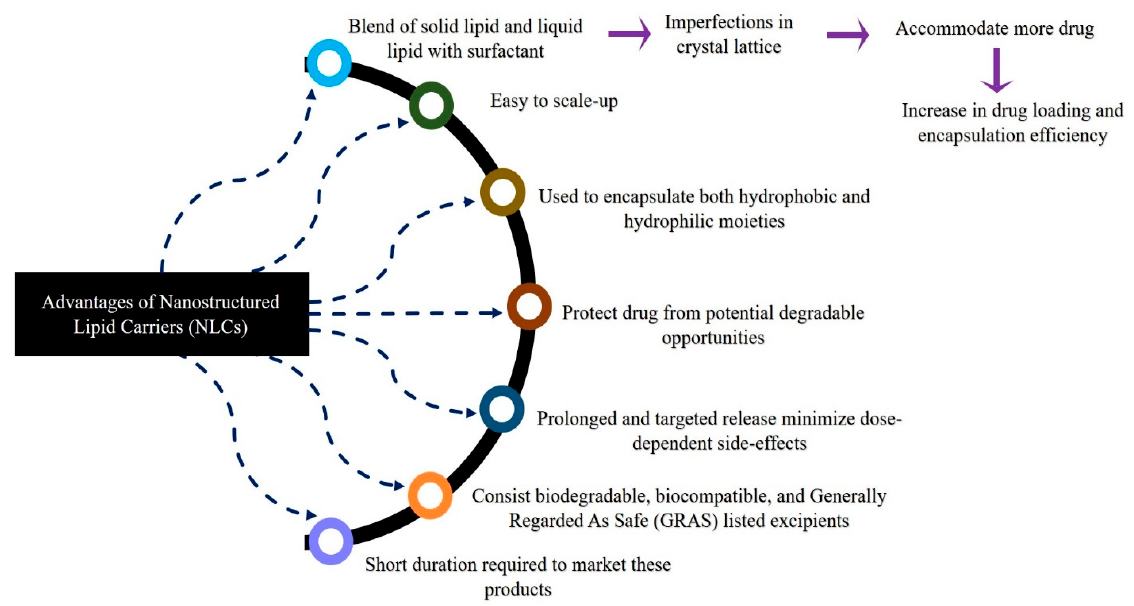
Figure 3. Schematic representation of SLNs: ( A ) solid solution model; ( B ) core-shell model (drug- enriched shell); and ( C ) core-shell model (lipid-enriched shell) and NLCs: ( D ) imperfect type of drug encapsulated in a gap between fatty acid chain of solid and liquid lipids; ( E ) formless-type mixture of solid and liquid lipids preventing crystal formation; ( F ) multiple-type nanocompartments of oils containing dissolved drug.